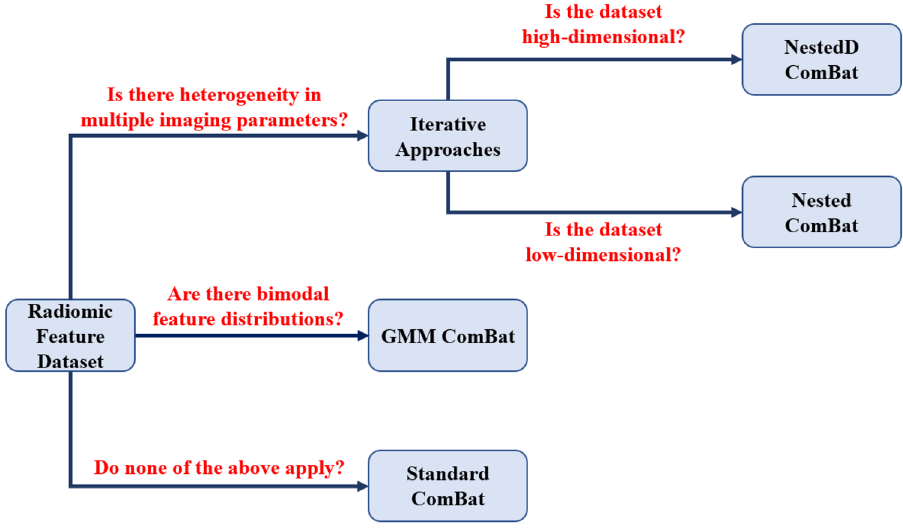
Figure 4. Decision flowchart indicating the context most suitable for each of the evaluated